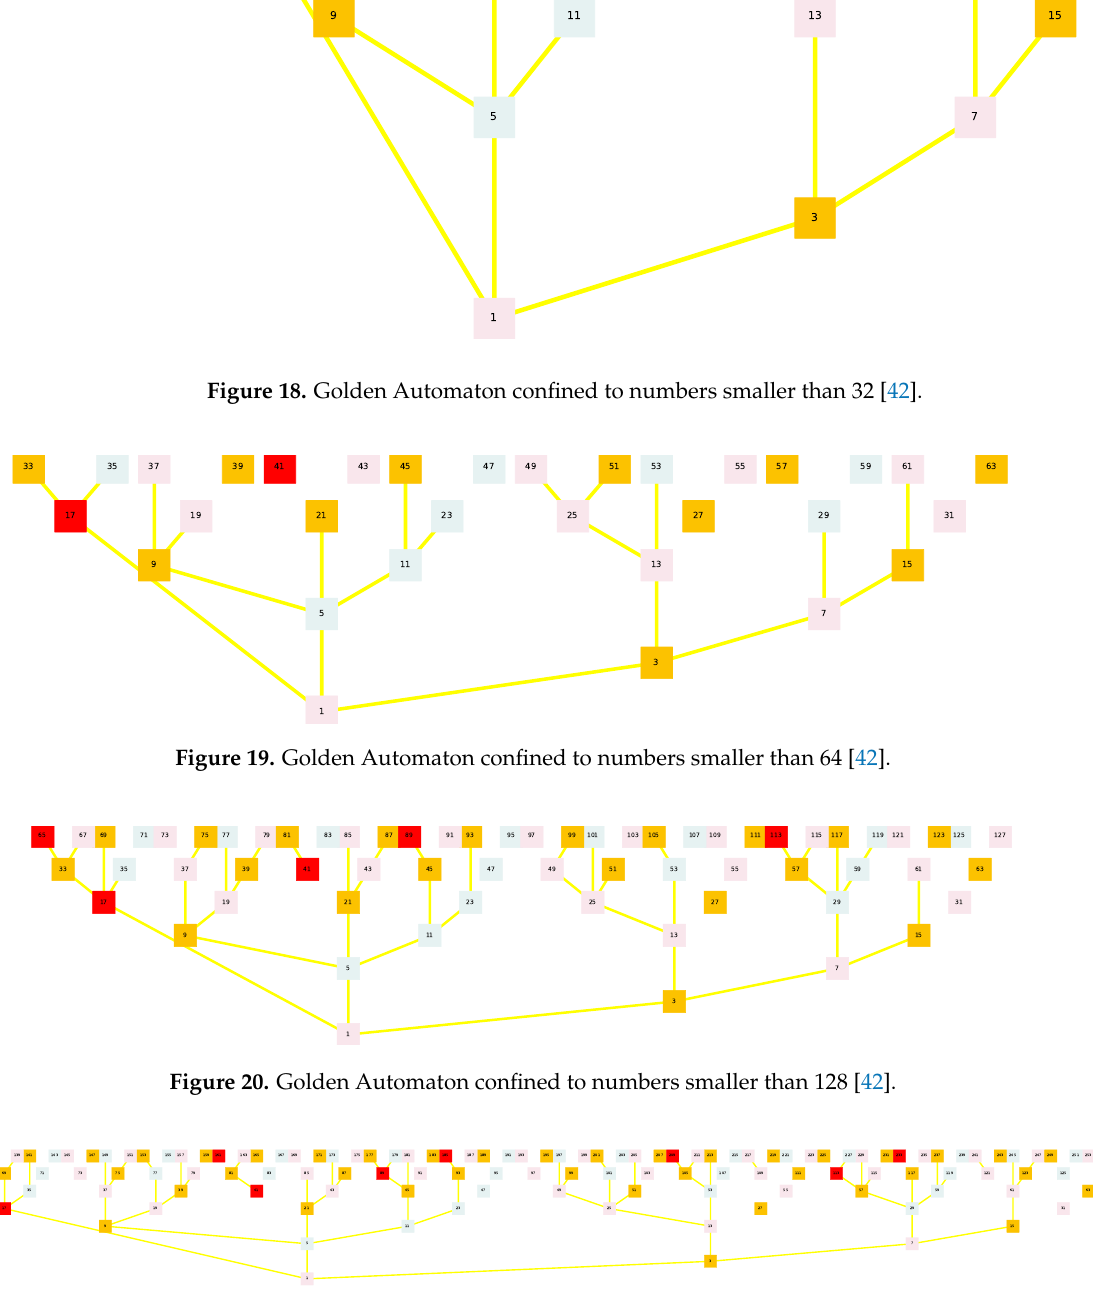
Figure 21. Golden Automaton confined to numbers smaller than 256